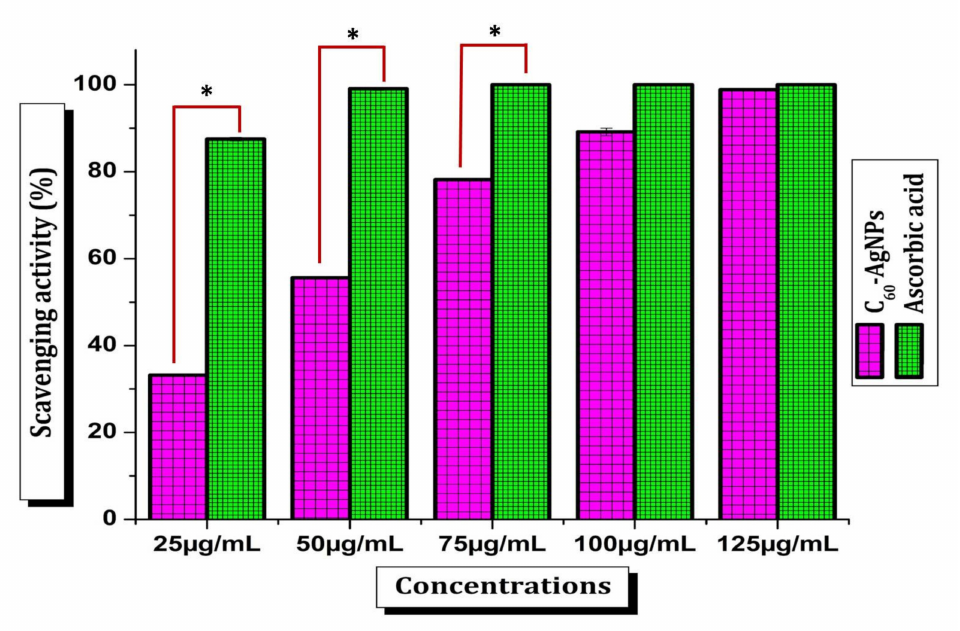
Figure 6. DPPH radical scavenging assay by C 60 -AgNPs nano-composites. Error bar represents the standard deviation of the mean. * p ≤ 0.05. Significant difference ( p ≤ 0.05) within a parameter between two lines is denoted by an